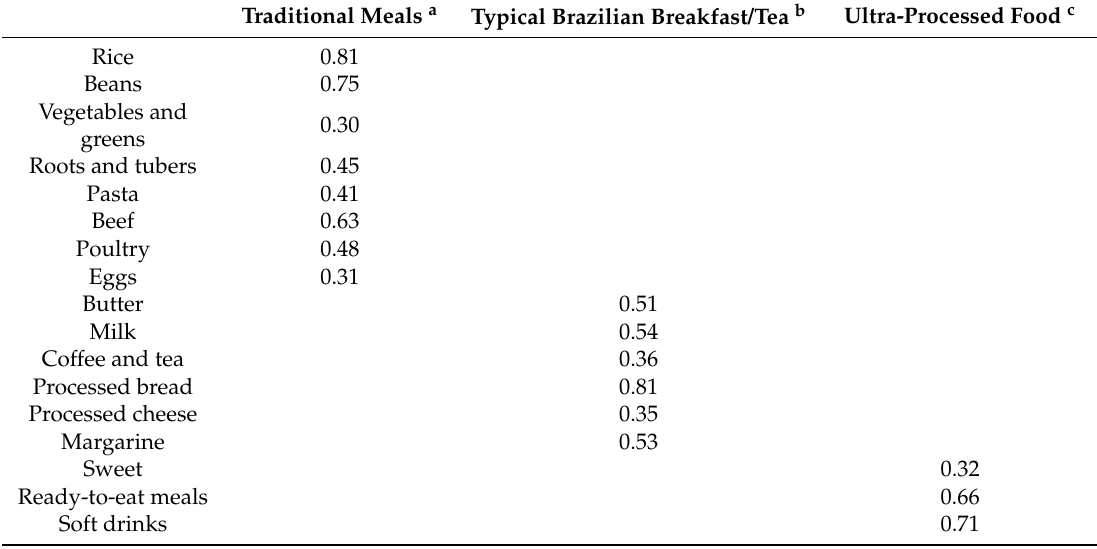
Table 1. Out-of-home eating patterns. Brazilian Population 10 years old and over (2008–2009). Traditional Meals